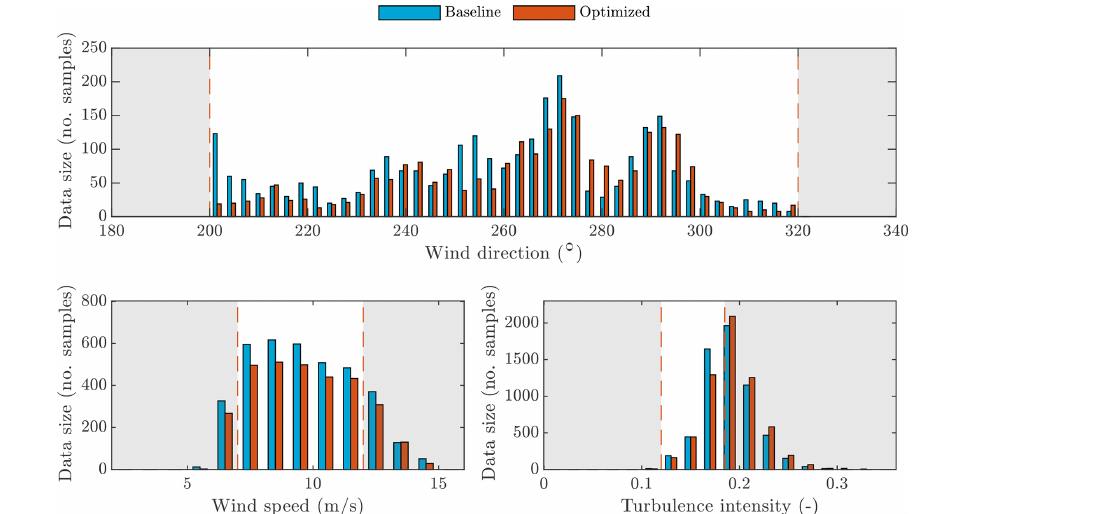
Figure 7. Filtered measurement data from 19 August 2019 until 3 February 2020, binned as a function of wind direction, wind speed, and turbulence intensity.